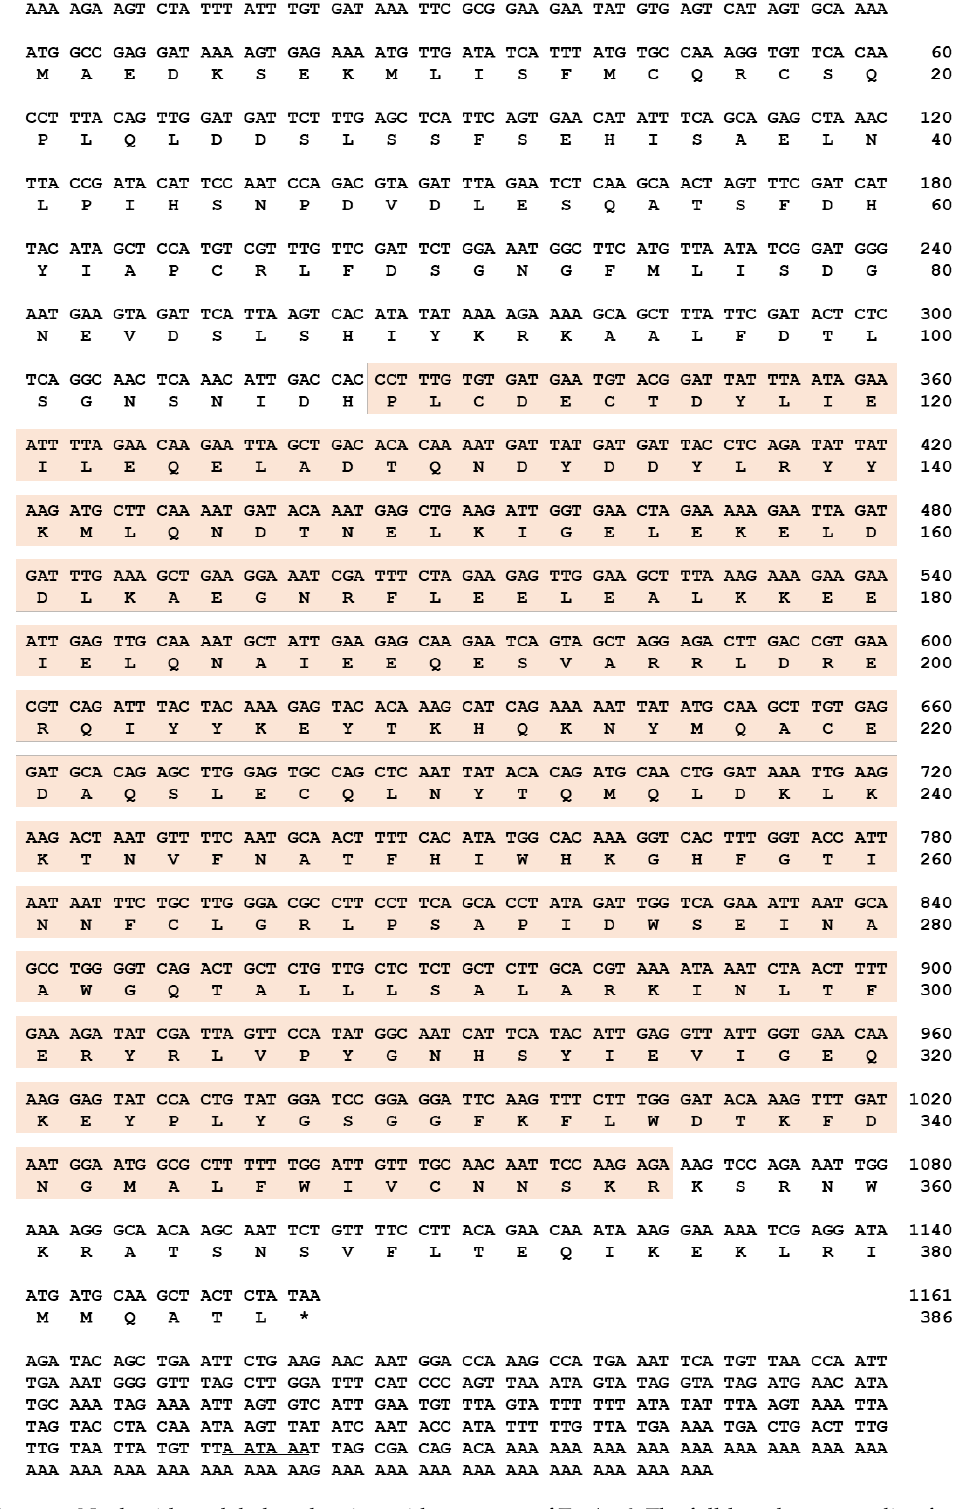
Figure 1. Nucleotide and deduced amino acid sequences of TmAtg6 . The full-length open reading frame (ORF) sequence of TmAtg6 gene was identified. TmAtg6 has 1161 bp of ORF encoding 386 amino acid (aa) residues. Domain analysis indicates that Tm Atg6 contains one Atg6 domain. The polyadenylation signal sequence (AATAA) is underlined in the 3 ′ -UTR region and the TmAtg6 domain is shaded in orange.